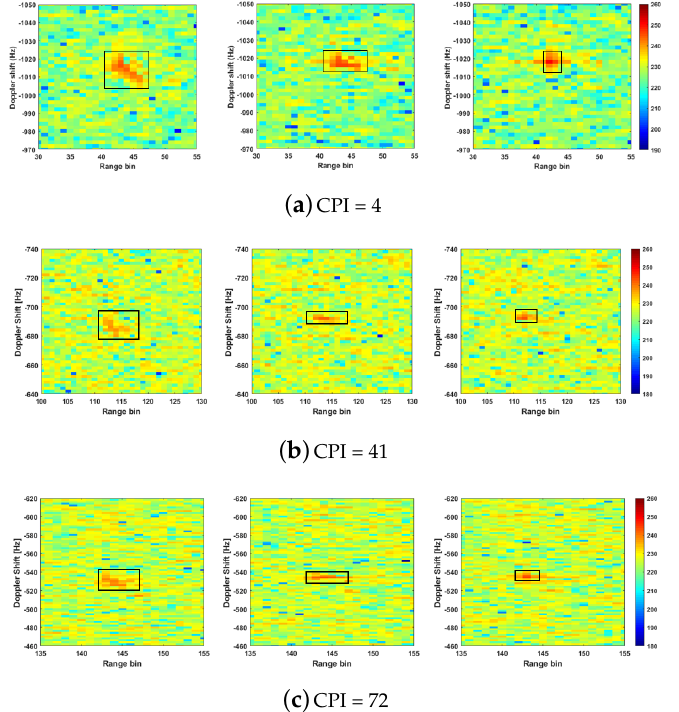
Figure 16. Target motion compensation results in the CAF zoomed area in different CPIs. Left, center, and right images are inputs, outputs of second stage, and outputs of third stage of the proposed scheme,